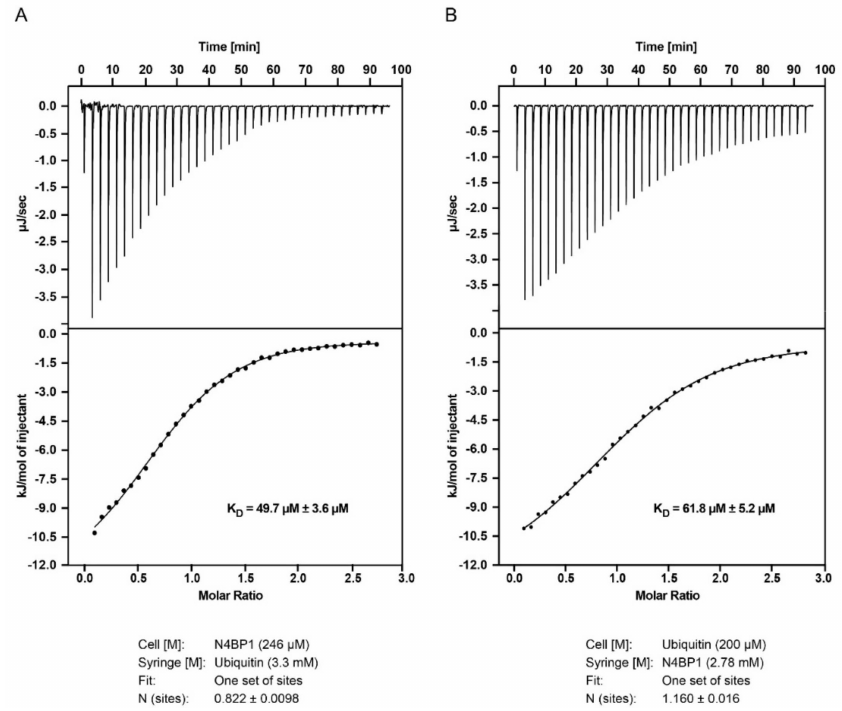
Figure 7. Isothermal titration calorimetry (ITC) experiments with N4BP1 and ubiquitin. ( A ). Titration of 3.3 mM ubiquitin to 246 µ M N4BP1 ( B ) Titration of 2.78 mM N4BP1 to 200 µ M ubiquitin. The data for the two titrations show similar dissociation constants (K D